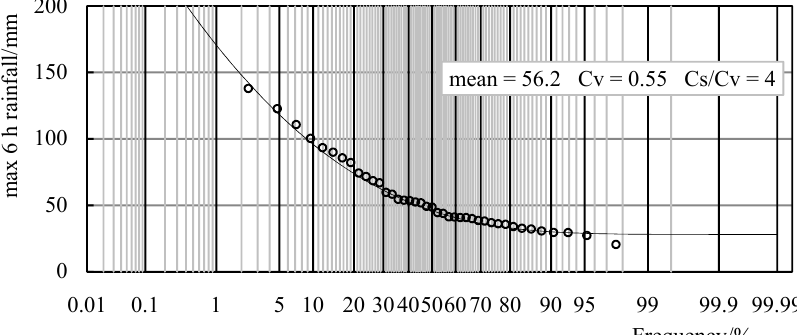
Figure 9. The frequency curve of the maximum 6 h rainfall of discontinuous 41 years in 1978~2021 at Jiulongjiao station.